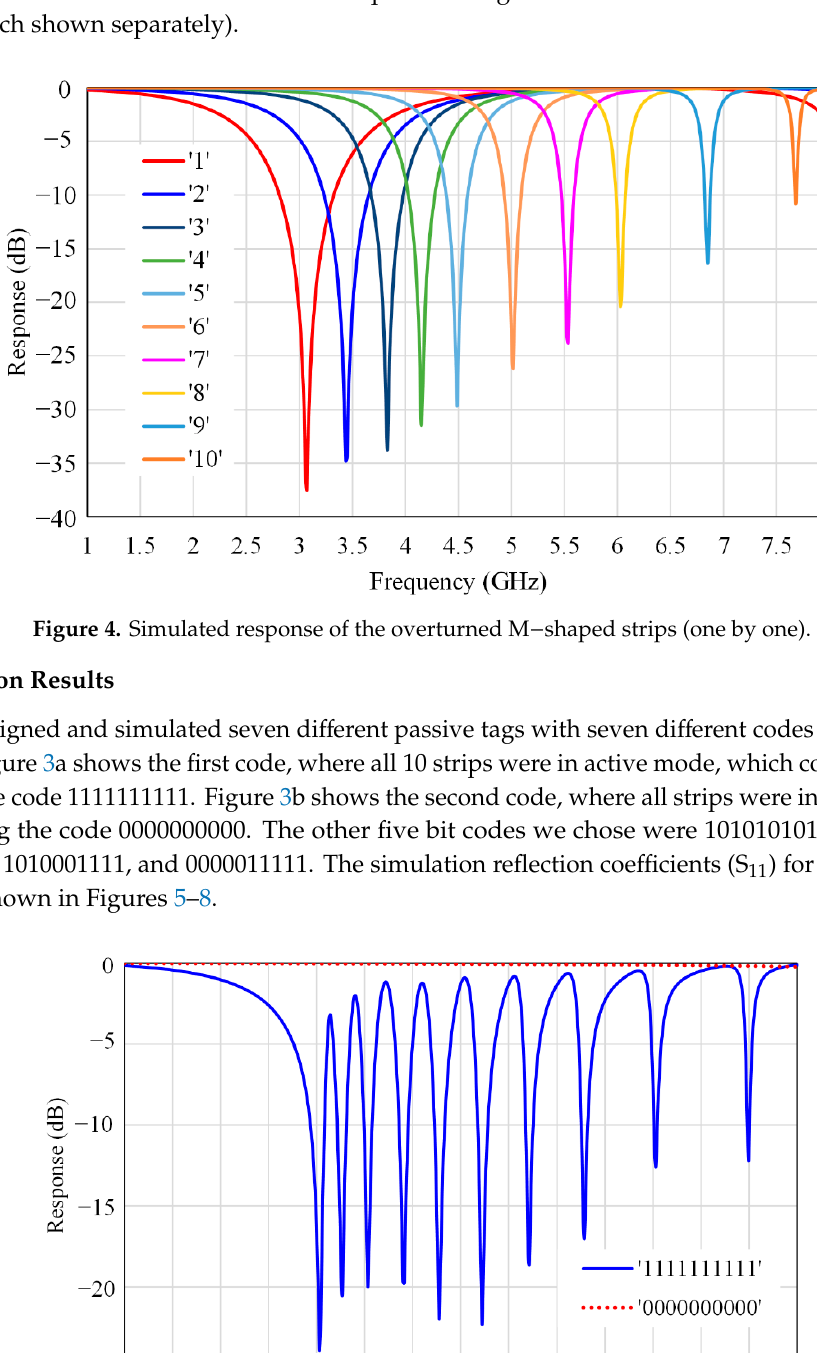
Figure 6. Simulated response of the M − strips tag with two different codes: 1010101010 and 0101010101.